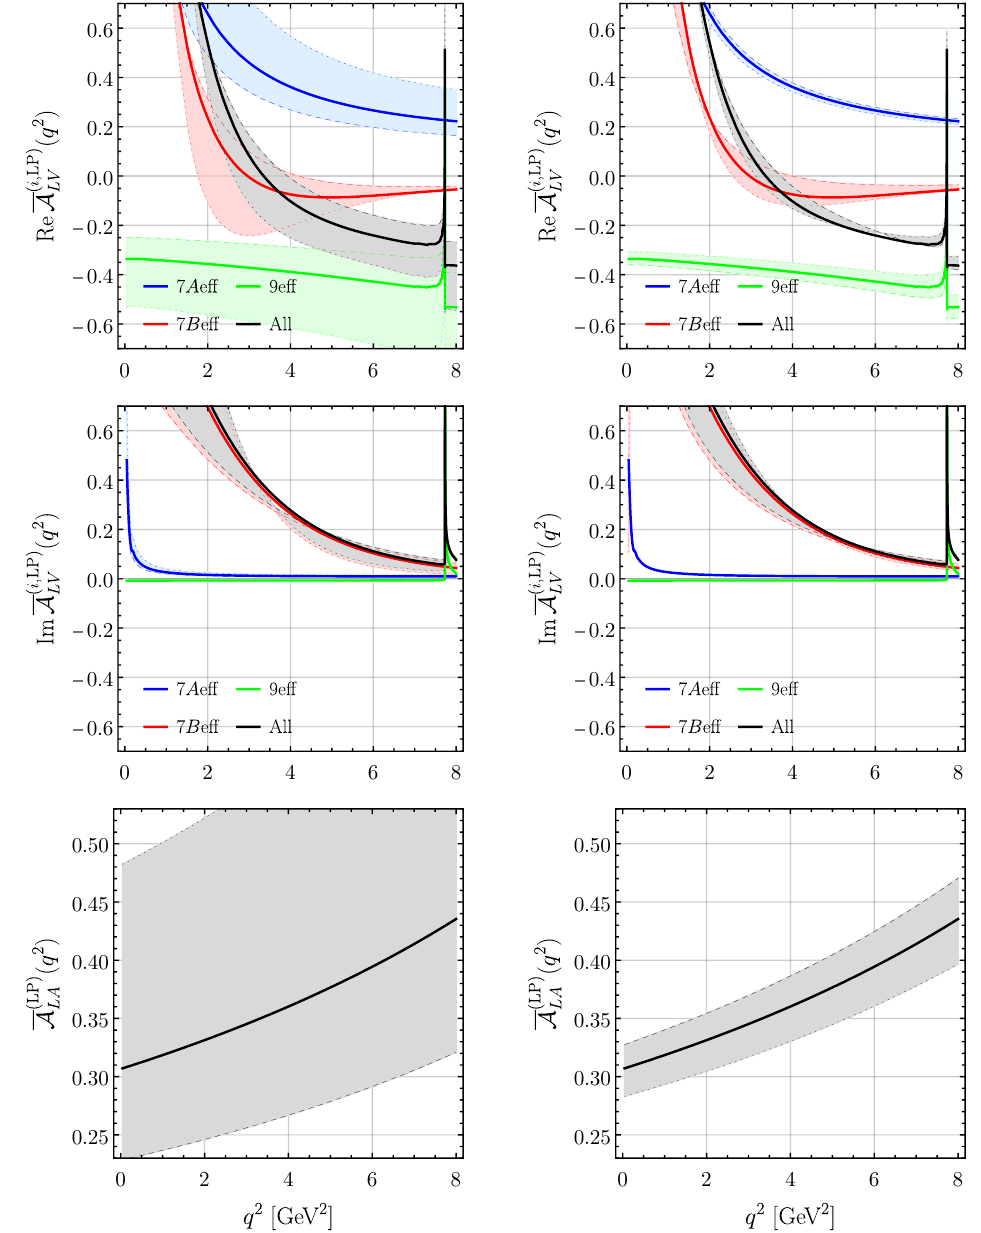
Figure 5 . The λ B [left] and σ (1) [right] dependence of the helicity amplitudes Re A LV [upper], b B s s Im A LV [middle] and A LA [lower] at LP. The variation of λ B (0 . 0 ± 0 . 7) [dotted, solid, dashed] leads to the grey bands. The individual contributions i = 7 A, 7 B, 9 [blue, red, green] are also shown for A LV